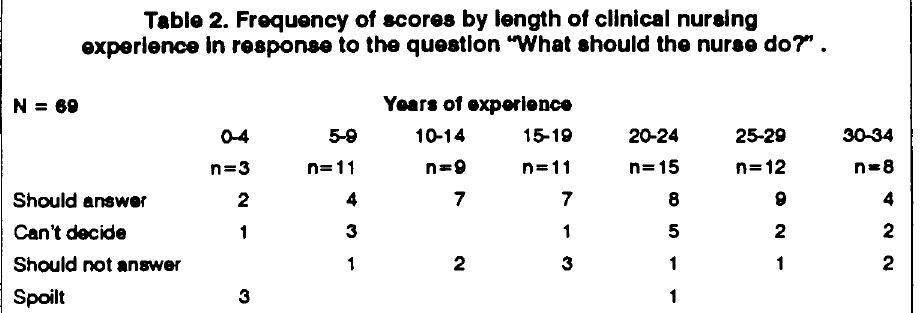
Table 2. Frequency of scores by length of clinical nursing experience In response to the question "What should the nurse doT .